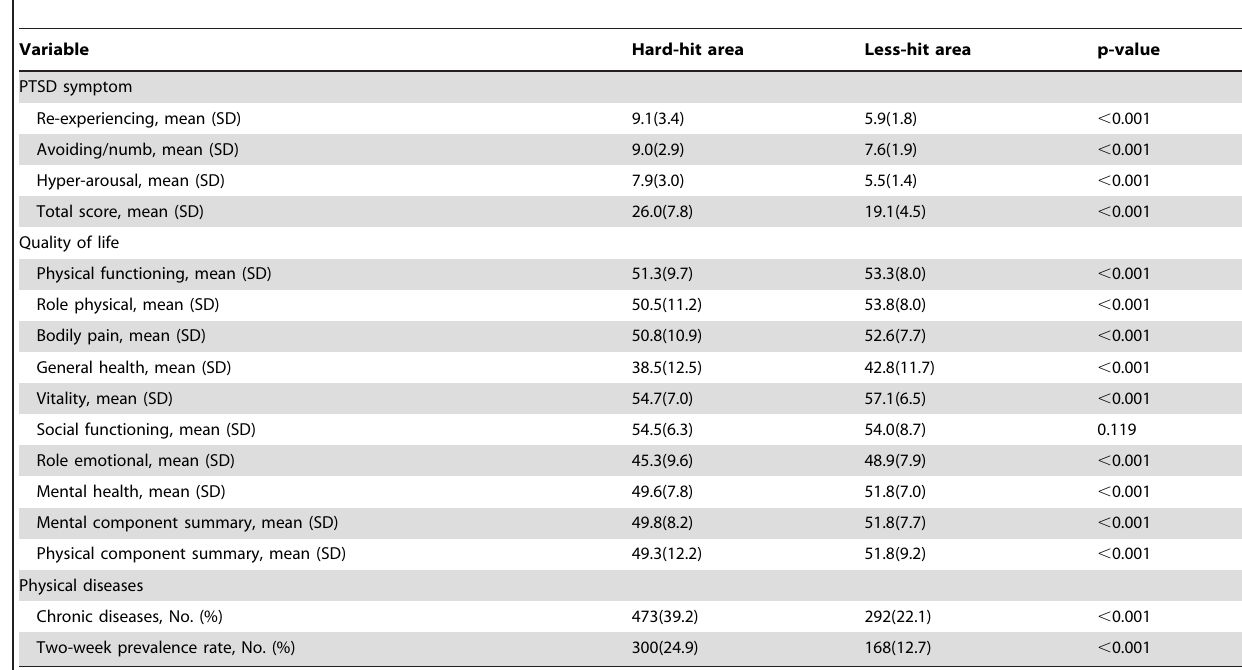
Table 2. Descriptive statistics of PTSD, quality of life, and physical diseases among participants from hard-hit and less-hit areas.